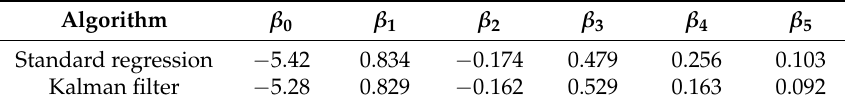
Table 6. Steady state behavior of ln(C res ) variance and its components, as from Equation (6).